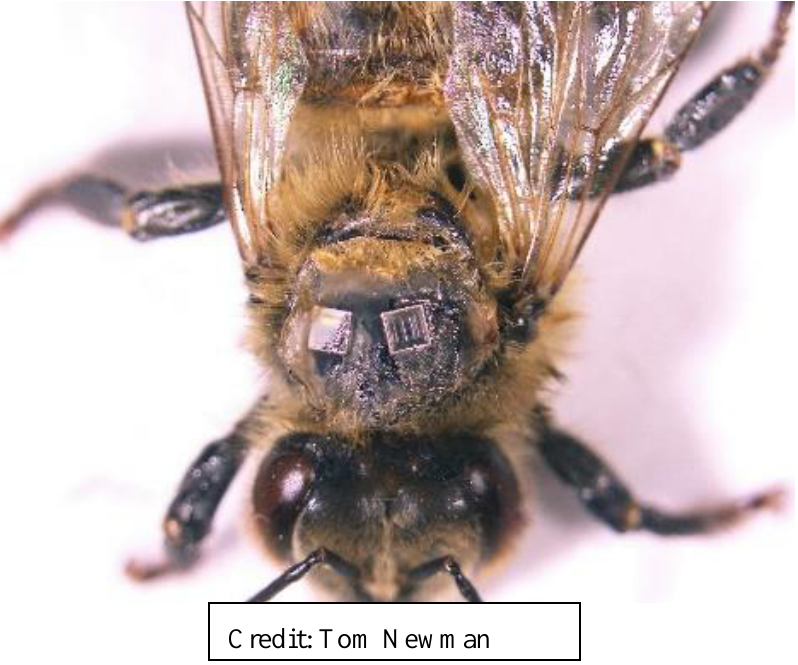
Figure 5. Current size of miniature RFID tags used by investigators